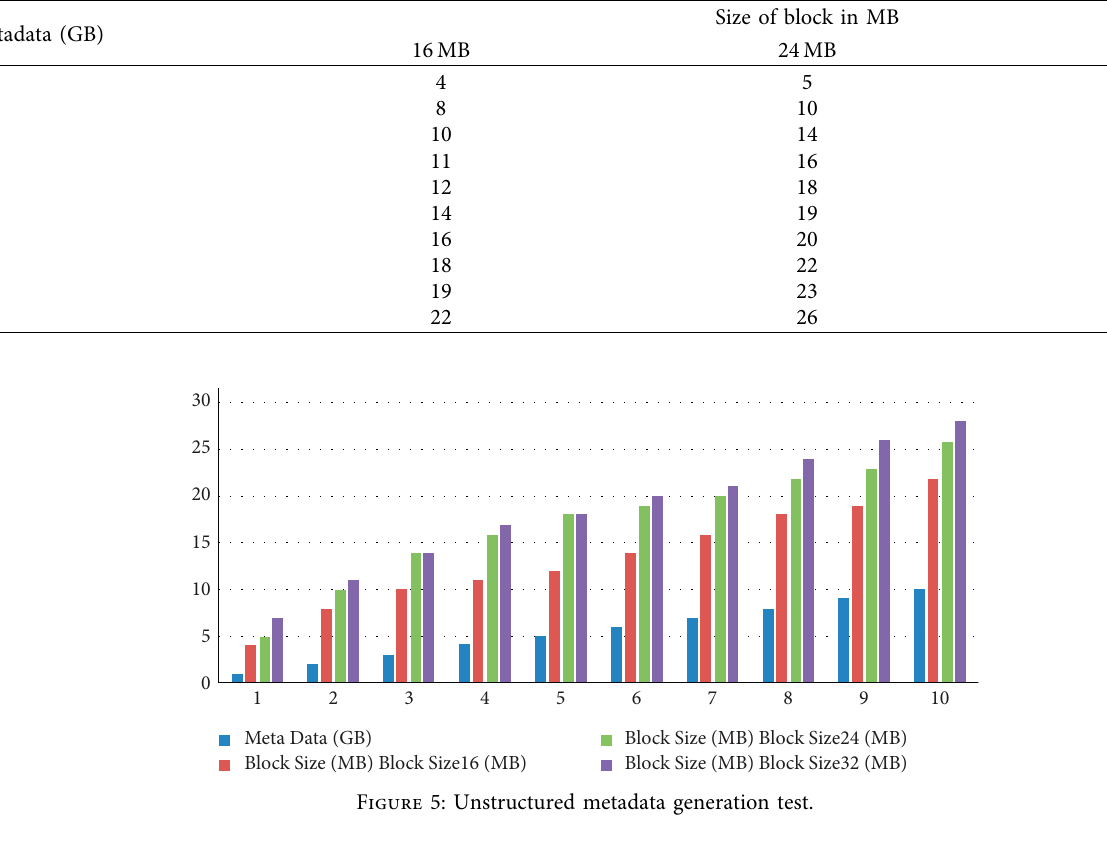
Table 2: 1–10GB metadata generation test.